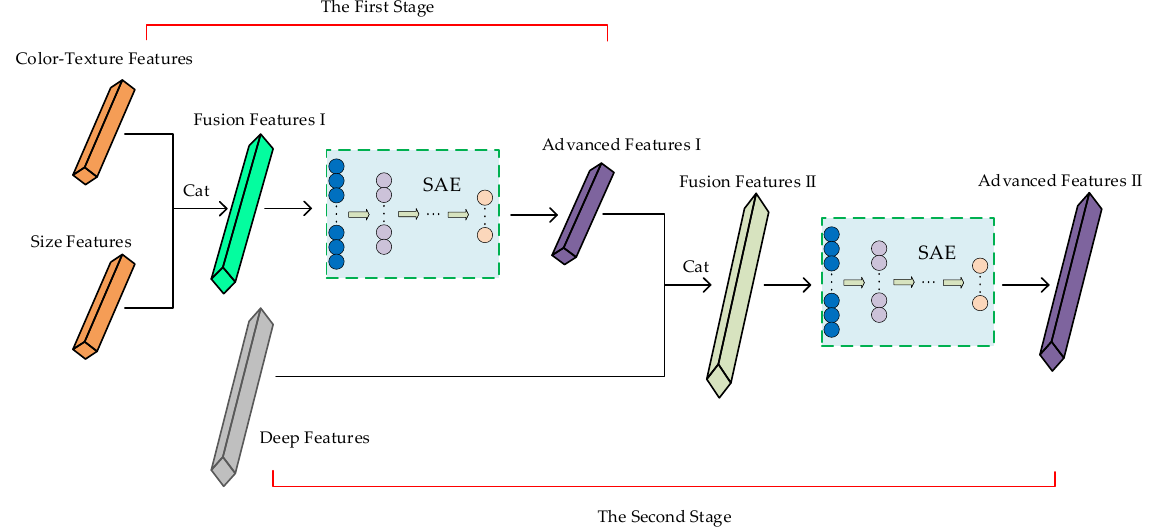
Figure 9. The two-stage feature fusion process based on Cat-SAE. Table 3. The changes in feature dimensions during the two-stage multi-feature fusion process based on Cat-SAE.